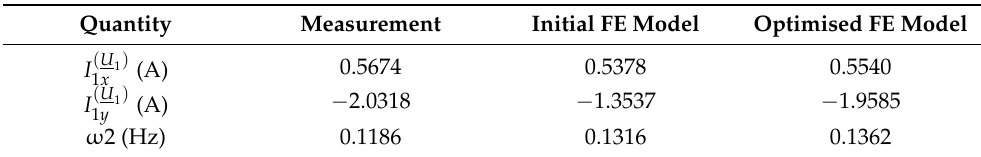
Table 4. The x -axis and y -axis components of the SC space vector and the slip frequency under the IM no-load operation determined from the measurement and the simulation conducted using the FE model.